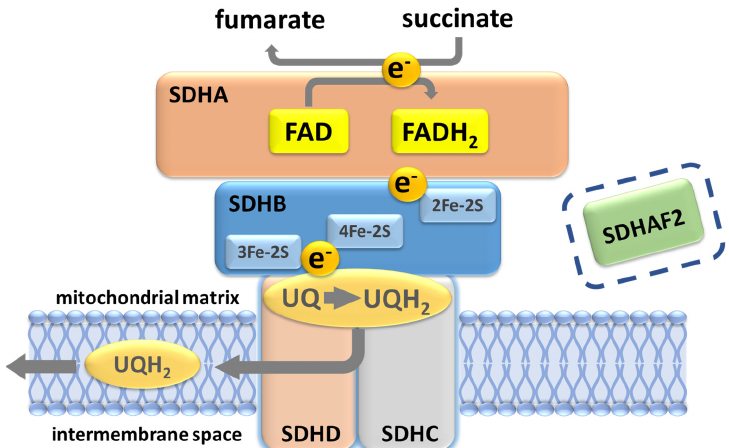
Figure 3. Succinate dehydrogenase/complex II. The oxidation of succinate to fumarate yields two electrons that subsequently reduce ubiquinone to ubiquinol. A ubiquinone binding site (UQ) at the inner mitochondrial membrane, formed by residues in SDHB, SDHC and SDHD, lies close to the SDHB 3Fe-2S redox center. Protonation of ubiquinol likely occurs at the conserved SDHD Tyr114 residue in the UQ pocket, the site of the Northern Italian founder variant p.(Tyr114Cys), which is associated with very low PPGL risk. SDHAF2 is essential for flavination and assembly of the SDH complex and prior to assembly binds at the SDHA-SDHB interface. Although depicted in the figure with regard to the discussion later in this paper, SDHAF2 has no known post-assembly role in SDH function.